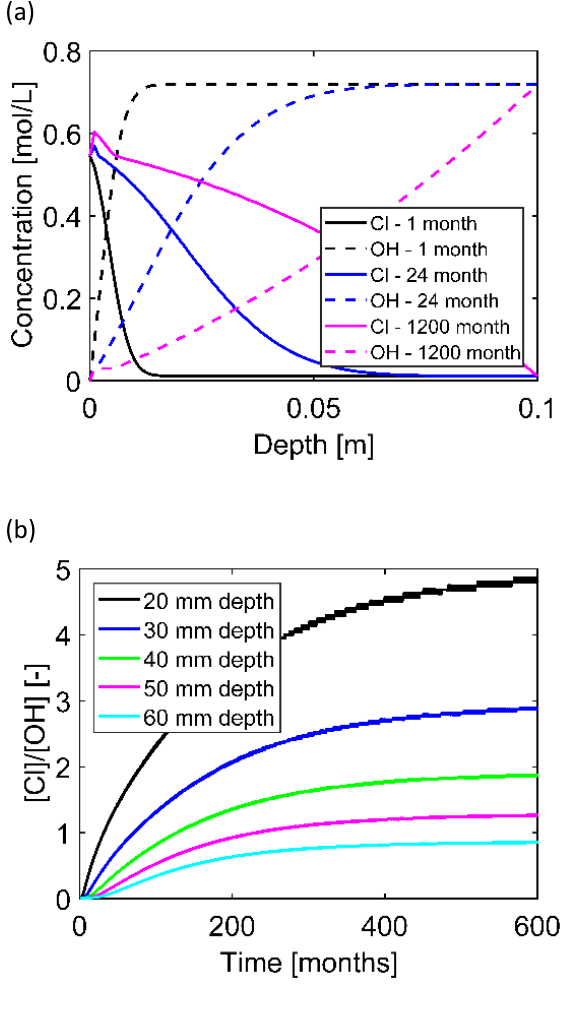
Figure 2. Predicted (a) chloride ion (Cl ‐ ) and hydroxyl (OH ‐ ) ion concentration as a function of depth from exposed surface after 1, 24 and 1200 month marine exposure, and (b) [Cl ‐ ]/[OH ‐ ] in pore solution for selected depths over time.